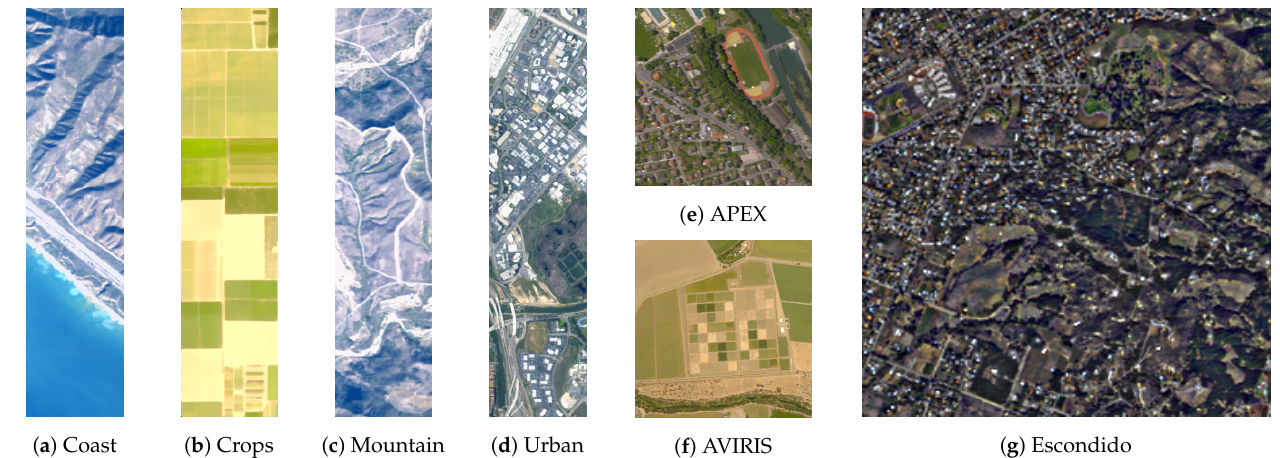
Figure 6. RGB images of the synthetic datsets used, generated from bands B2, B3 and B4 using a combination of methods described in